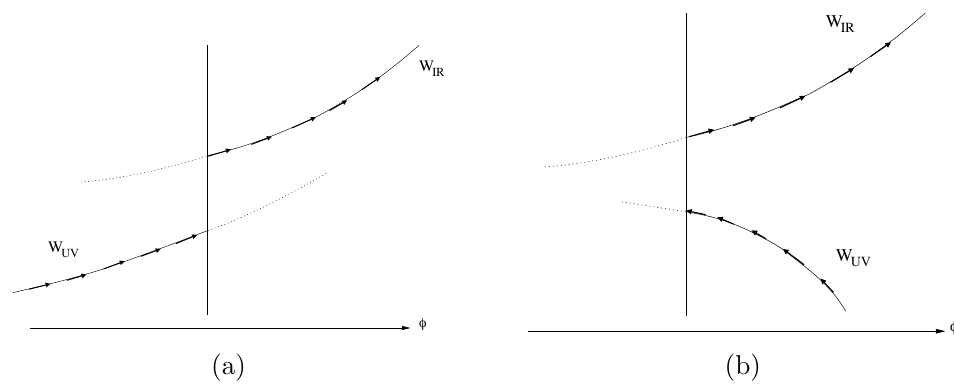
Figure 15 . The (cid:12)gures above show the allowed ways of joining two solutions of the superpotential equation at the interface. The arrows indicate the direction of increasing u , which coincides with the direction of increasing W . The junction must be such that the arrows on the IR solution point away from the brane, whereas those on the UV solution point towards the brane. In terms of ’ , this condition can be realized on opposite sides of the point ’ = ’ 0 when W 0 > 0 (left (cid:12)gure), or UV on the same side, when W 0 < 0 (right (cid:12)gure). The dotted lines indicate how the solutions would UV continue past the